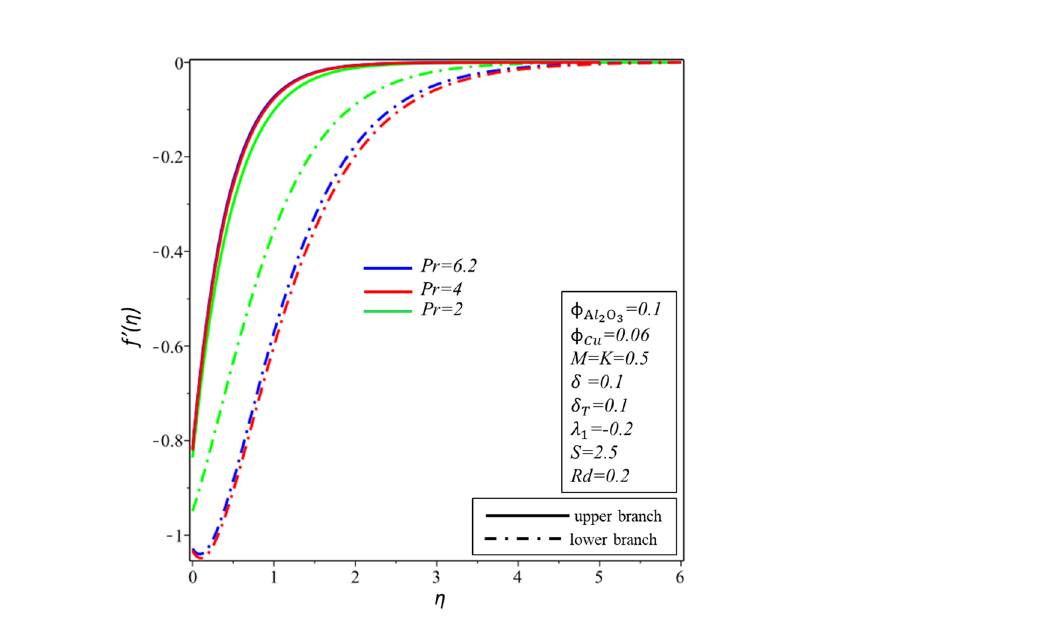
Figure 13. Behavior of θ(η) in impact of (cid:31) 1 .